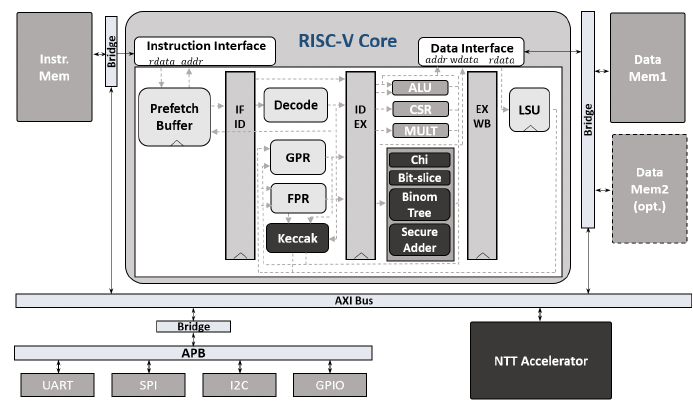
Figure 12: RISC-V system with masked post-quantum